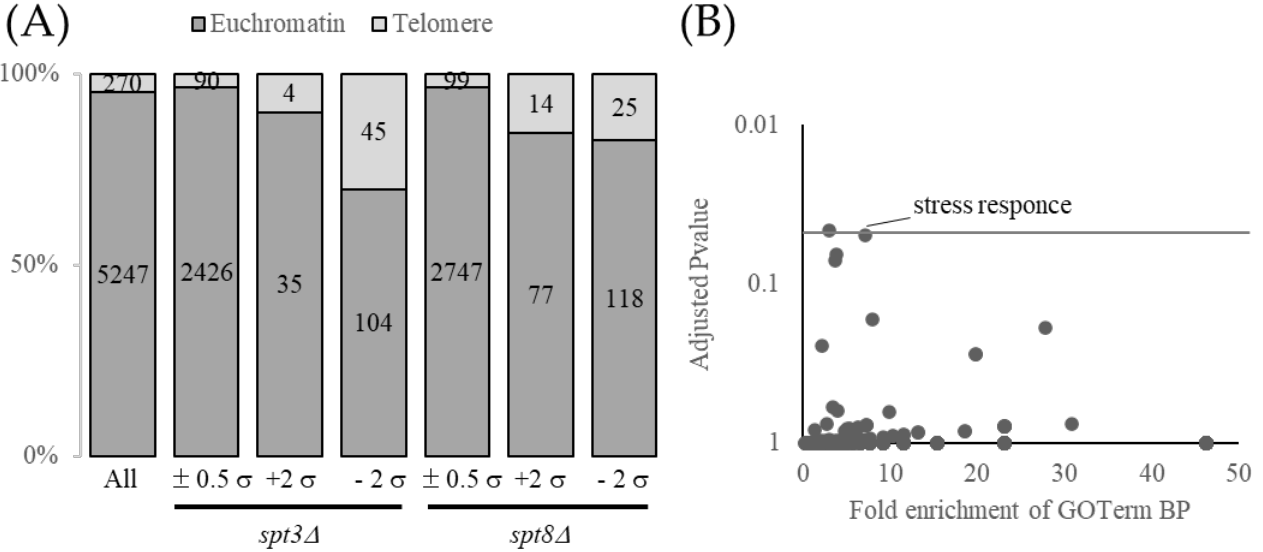
Figure 2. The spt3 ∆ and spt8 ∆ mutants showed a deficit in the silencing boundary. ( A ) A 100% stacked column chart of microarray analysis of the transcriptome of spt3 ∆ strain and spt8 ∆ strain. The numbers in the bar plot represent gene numbers. σ indicates standard deviation. ± 0.5 σ , +2 σ , and − 2 σ indicate unchanged, upregulated, and downregulated genes, respectively, compared to WT. ( B ) The results of DAVID analysis of downregulated genes in spt3 ∆ . The GOTerm biological process (BP) category results were plotted on the x-axis. Fold enrichment means the ratio of the actual number of downregulated genes to the expected number of genes belonging to each term. Adjusted p -values were calculated by the Benjamini method.